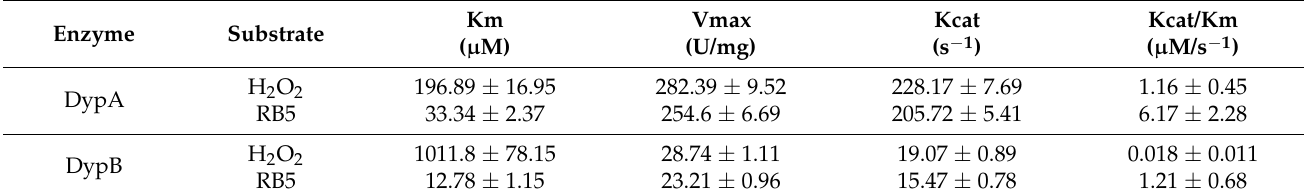
Seven dyes were tested to check the dye-decolorizing capability of Dyps. The dyes were comprised of two anthraquinone dyes (Reactive Blue 5 and Reactive Blue 19), diazo dye (Reactive Black 5), copper complex azo dye (Reactive Red 23), single azo dyes (Reactive Orange 16 and Reactive Yellow 37), and the polyanthraquinone dye with poly(vinylamine) sulfonate backbone (Poly